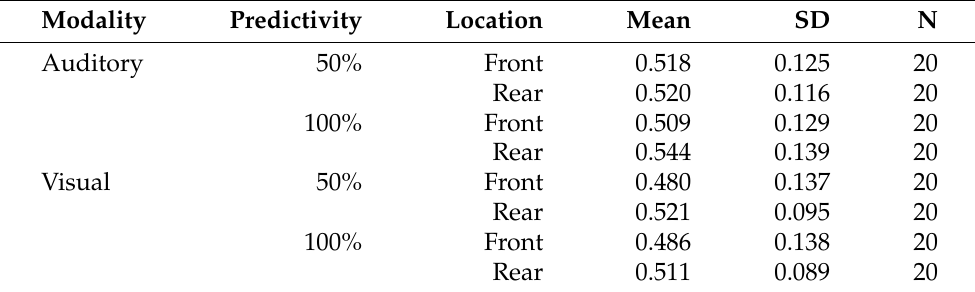
Table 2. Mean RT (in seconds) as a function of experimental factors for